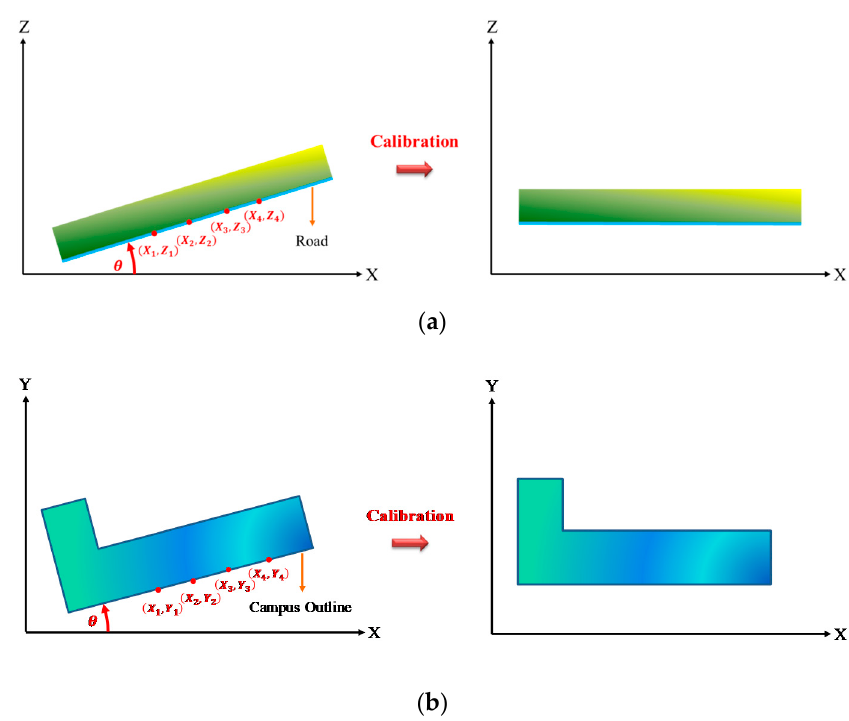
Figure 2. Calibration of the 3D point cloud. ( a ) Divergence in the Light Detection and Ranging (LiDAR) pitch angle. ( b ) Divergence between the LiDAR heading angle and the head direction of the vehicle.